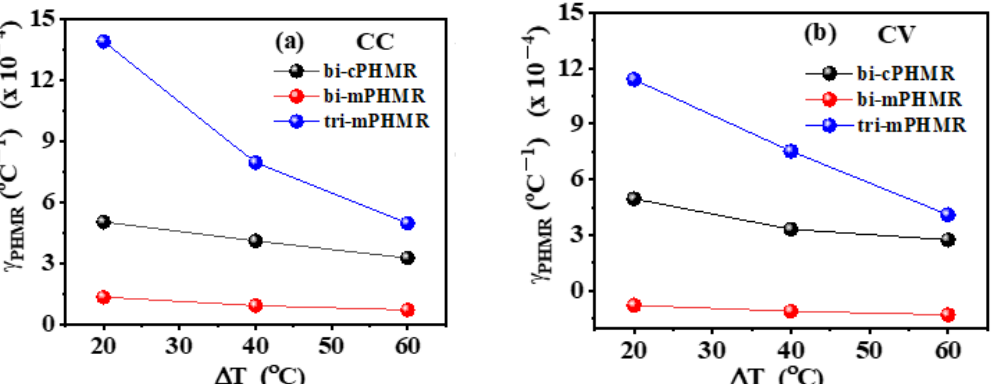
Figure 5. ( a , b ) Temperature-dependent variation of γ PHMR in CC and CV modes. ∆ T refers to the relative temperature increment with respect to room temperature (30 °C).